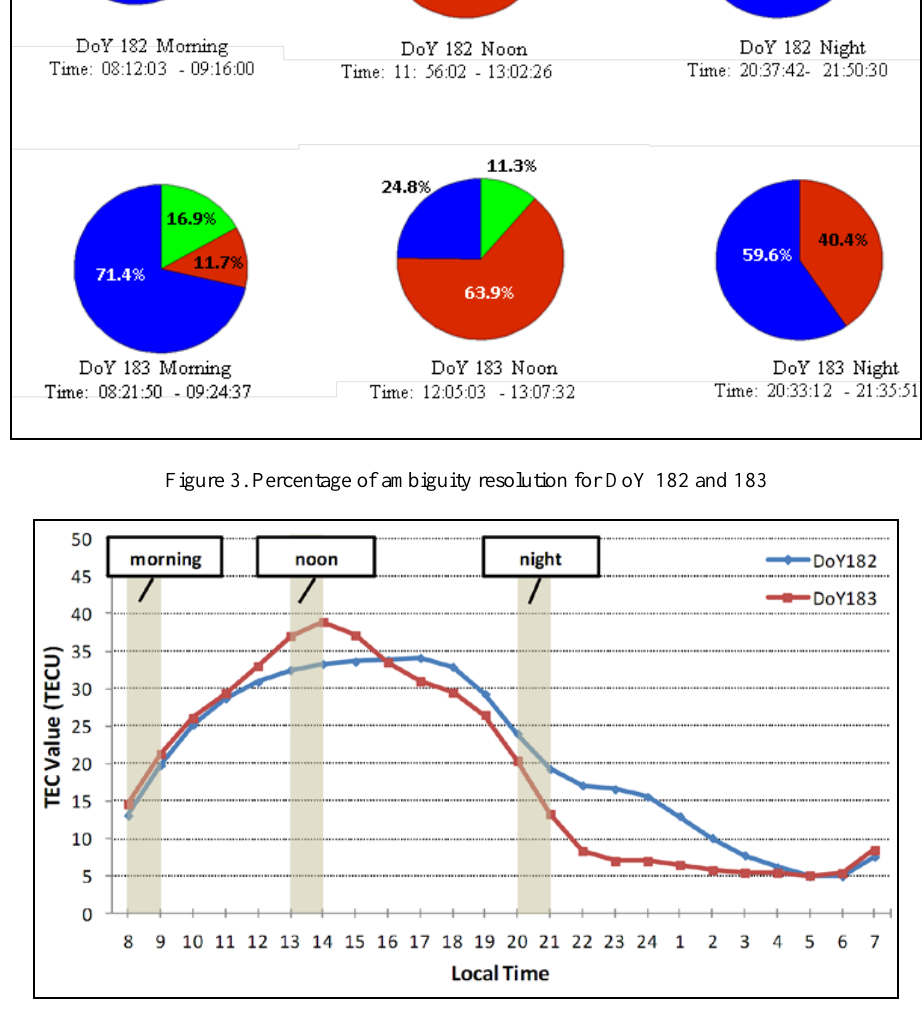
Figure 4. TEC values during GNSS observations on DoY 182 (blue line) and 183 (red